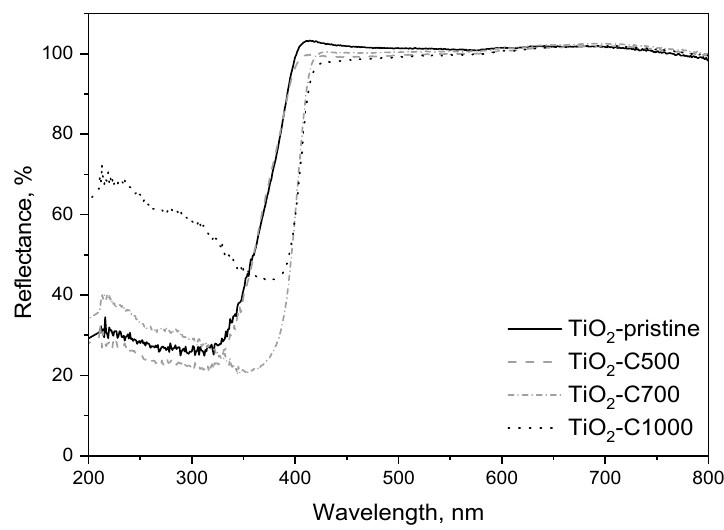
Figure 3. Reflectance spectra of TiO 2 samples calcinated at different temperatures.